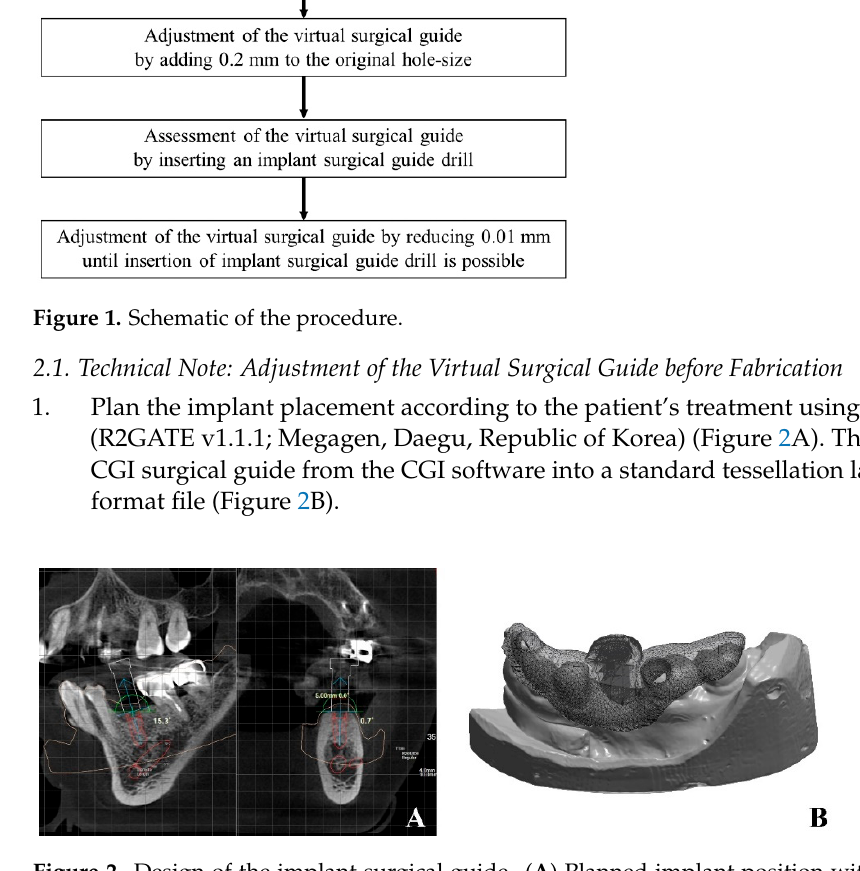
Figure 3. Method to adjust the size of the guide hole using Meshmixer. ( A ) Importing virtual surgical guide. ( B ) Creating a cylinder. ( C ) Partial segmentation of the cylinder and surgical guide. ( D ) Setting a reference point at the base of the cylinder. ( E ) Setting a reference point in the guide hole of the surgical guide. ( F ) Alignment with the cylinder and surgical guide. ( G ) Identification of alignment. ( H ) Cylinder movement. ( I ) Deletion of the overlapping parts of the cylinder and surgical guide. ( J ) Identification of the adjusted guide hole. 3.